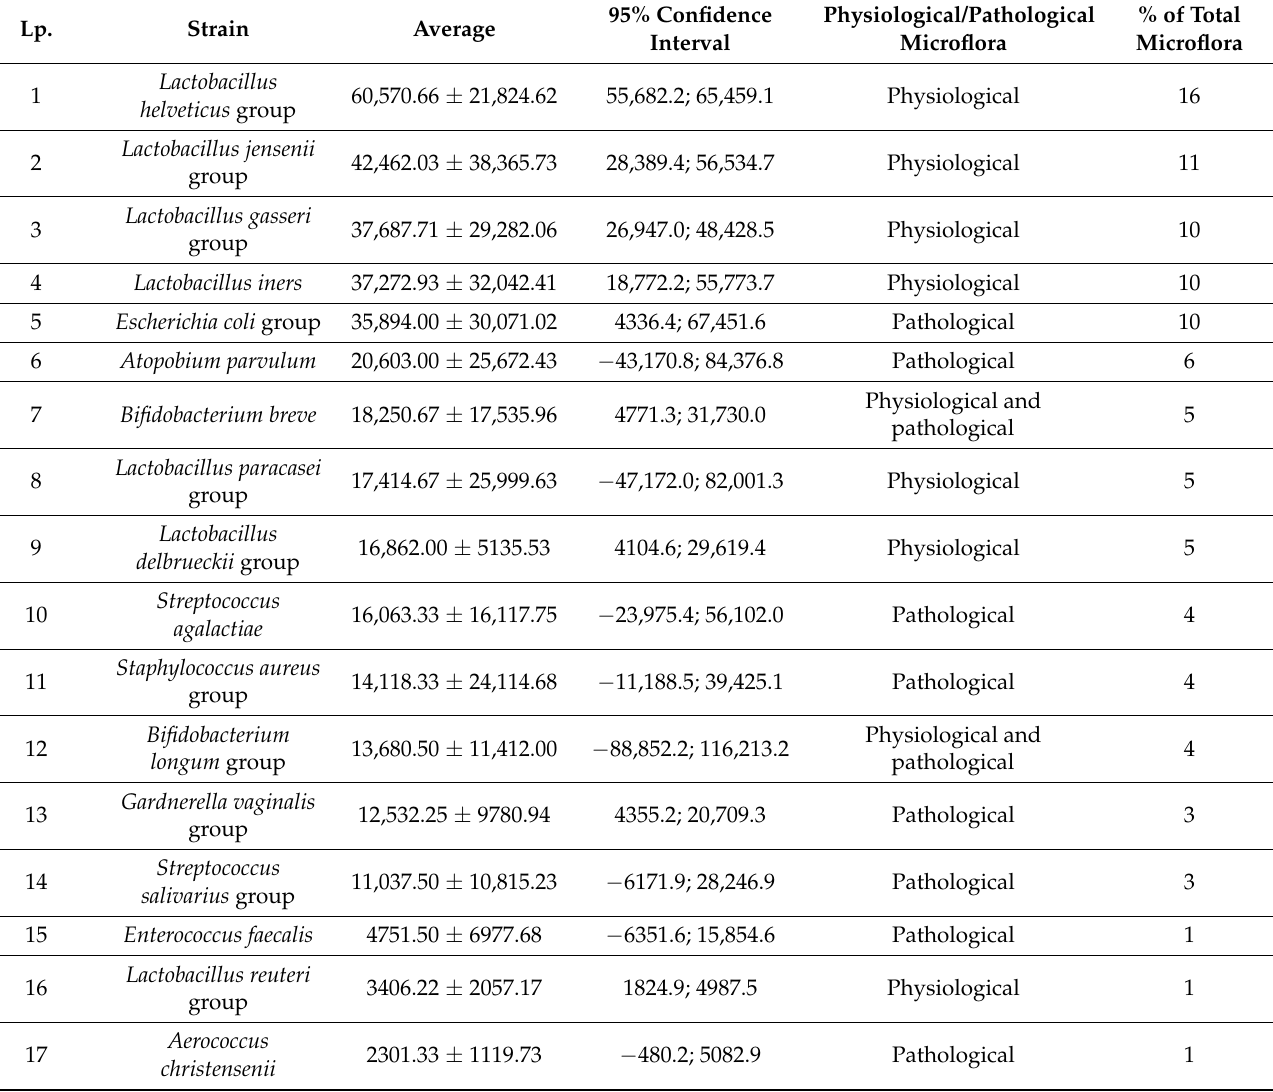
Table 3. Vaginal microflora of patients qualified for the